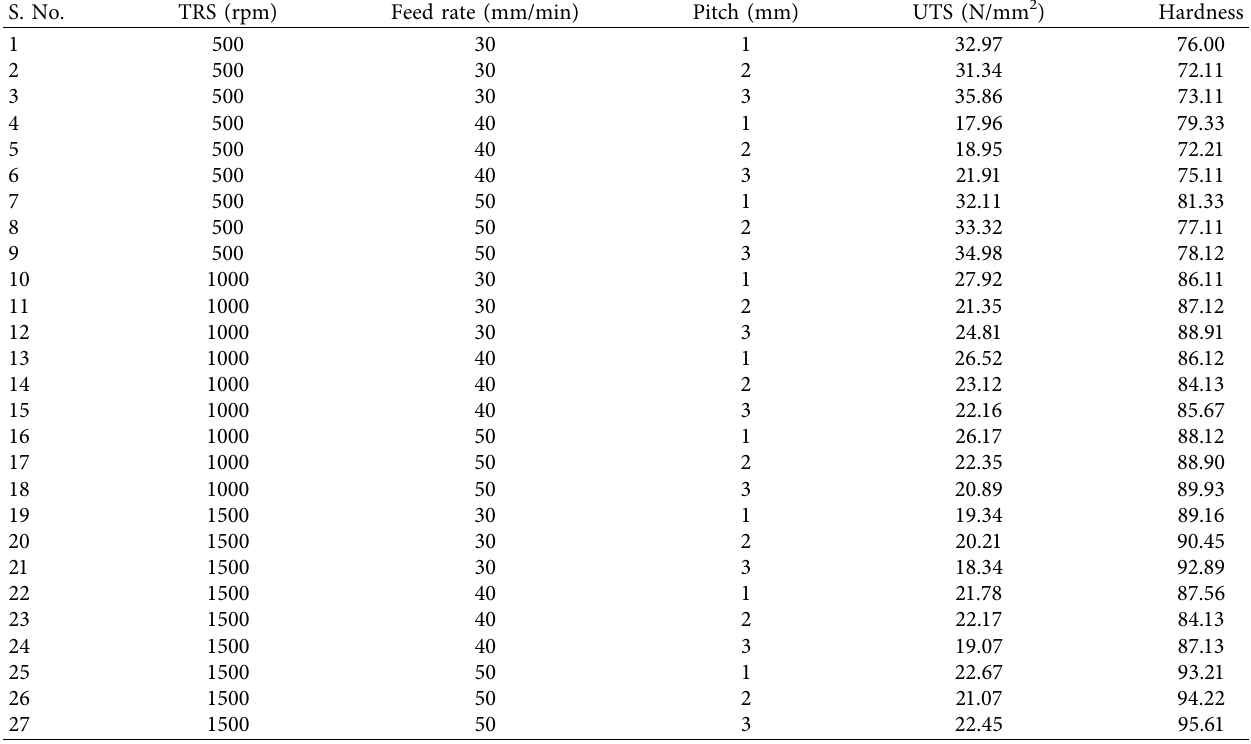
Table 3: Obtained experimental results of UTS and hardness.